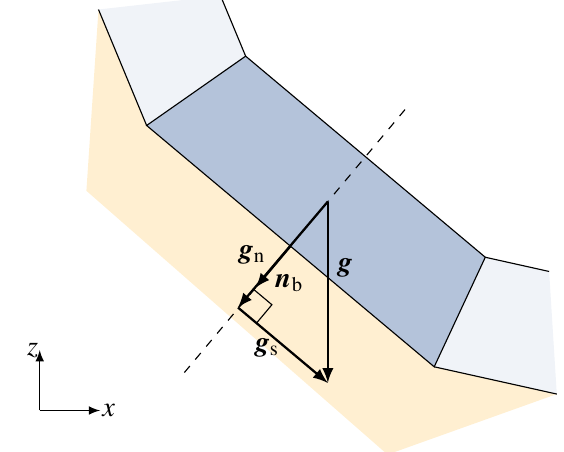
Figure A2. Splitting the divergence of a flux tensor ∇ · M into a surface-tangential and surface-normal part with simple projections to the surface-normal vector n b